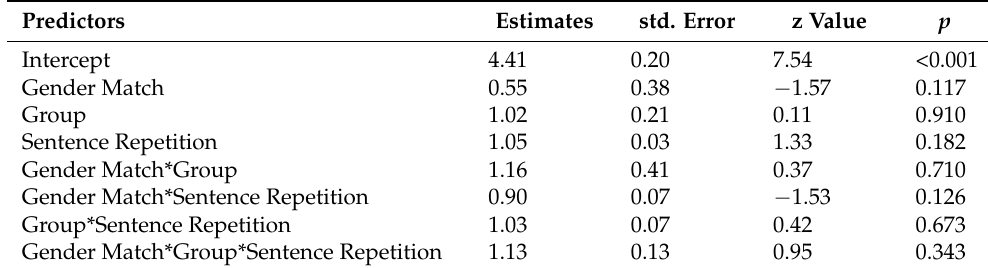
Table A4. Summary of the model for accuracy and the effect of sentence repetition in the production task excluding the